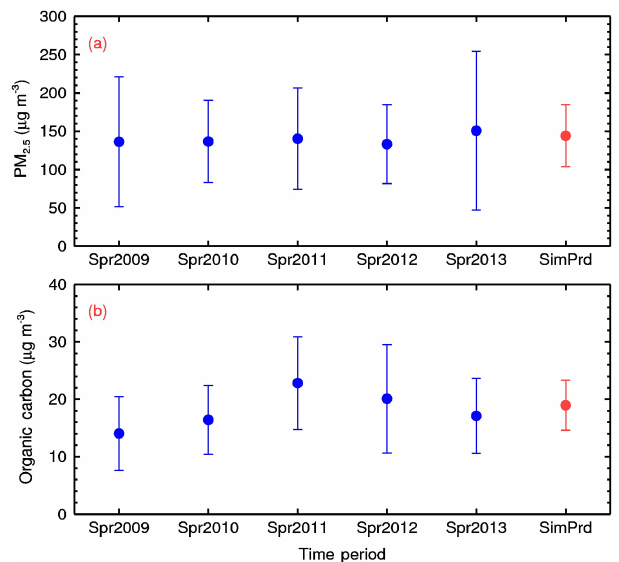
Figure 3. Plot showing the means and standard deviations of ob- served springtime PM 2 . 5 and organic carbon concentrations from 2009 to 2013 (blue), along with the filter measurements during the simulation period in this study (SimPrd, red).